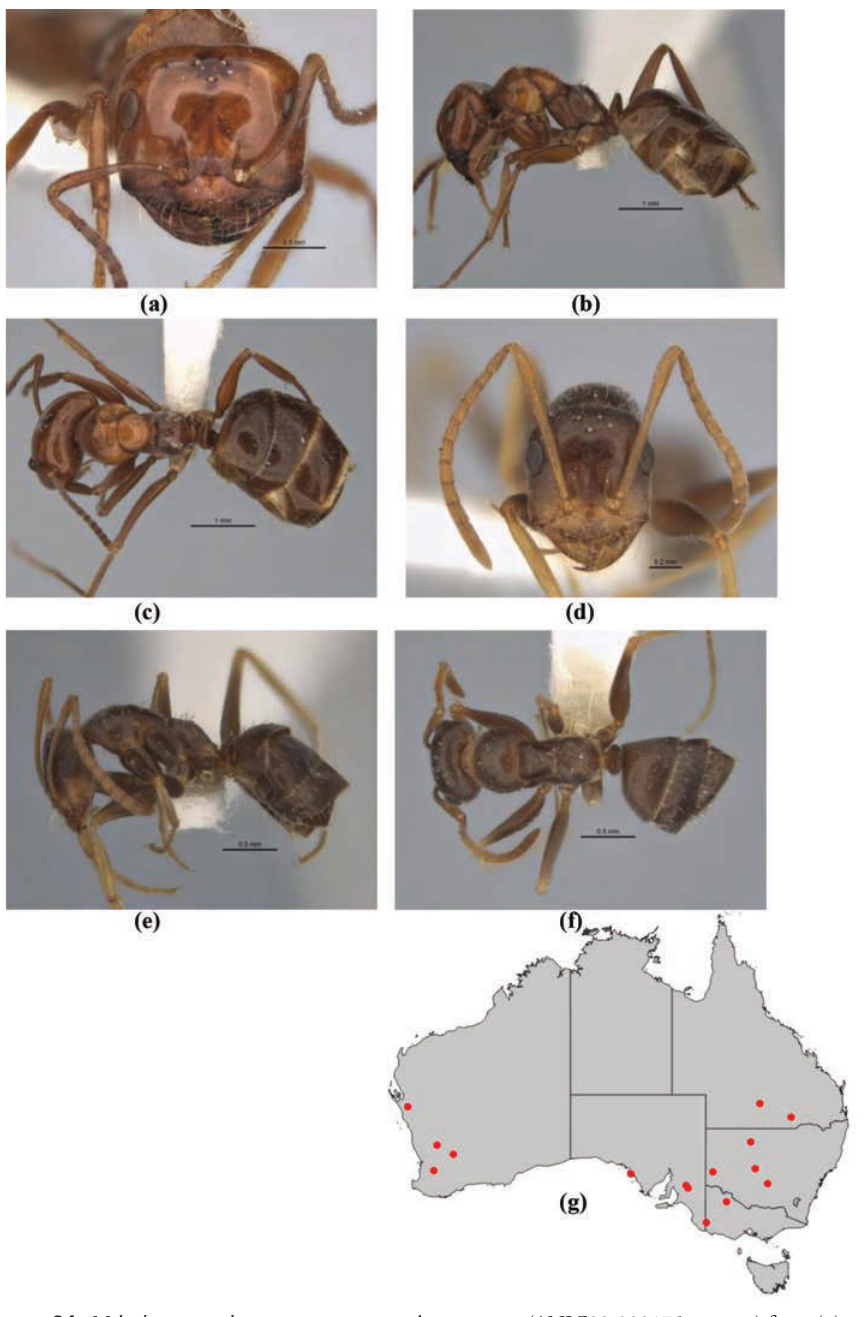
Figure 36. Melophorus graciliceps sp. n.: major worker paratype (ANIC32-900175–top ant) frons ( a ), pro- file ( b ) and dorsum ( c ); minor worker holotype (ANIC32-900175–bottom ant) frons ( d ), profile ( e ) and dorsum ( f ); distribution map for the species ( g ). Low resolution scale bars: 1 mm ( b, c ); 0.5 mm ( a, e , f ); 0.2 mm ( d